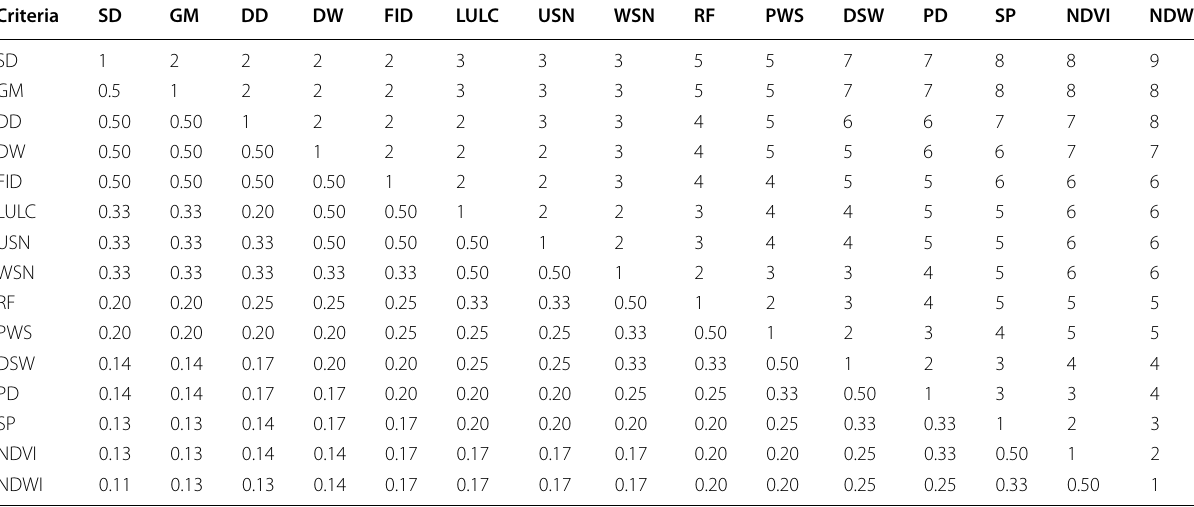
Refer Sect. Factors used in water resilience zone delineation for the acronyms